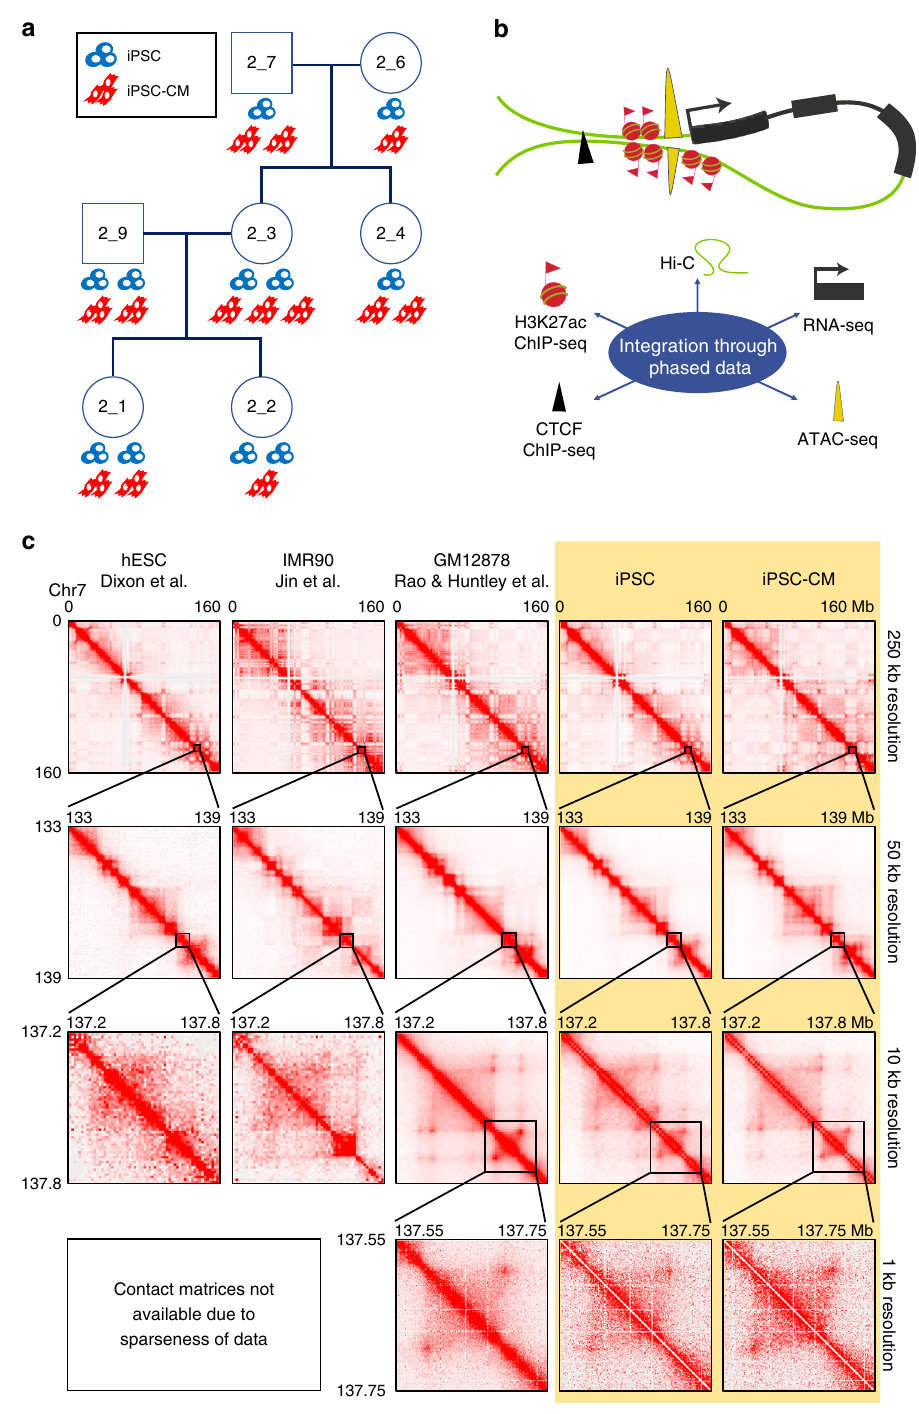
Fig. 1 Study design, data, and chromatin contact maps. a Pedigree of the seven individuals used in this study. Cell icons below each subject indicate the number of iPSC lines and iPSC-CM samples used in the Hi-C experiments. iPSC lines are shown in blue, iPSC-CM samples are shown in red. b Schematic showing the data types used in this study depicting how they colocalize at loop anchors. c Hi-C contact maps from previous Hi-C studies (three left columns), and this study (two right columns, highlighted in yellow), displaying depth of map on Chromosome 7 (arbitrarily chosen for example). For Dixon et al. 10 and Jin et al. 4 , the data is too sparse to zoom to 1 kb